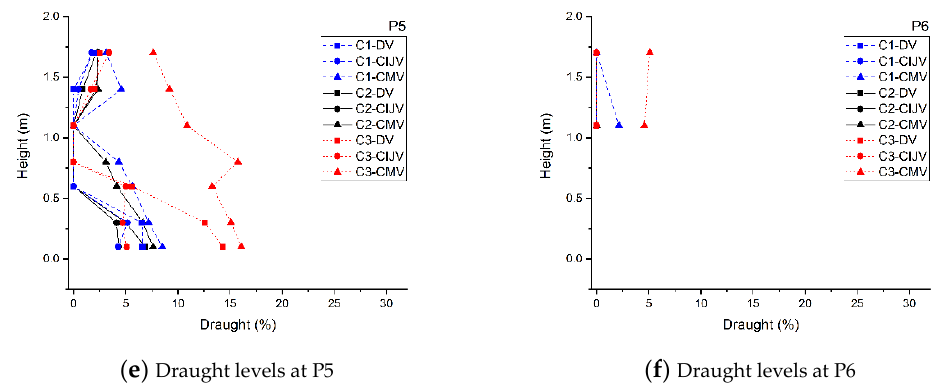
Figure 5. Draught levels at position P1 ( a ), P2 ( b ), P3 ( c ), P4 ( d ), P5 ( e ), and P6 ( f ) for all cases.